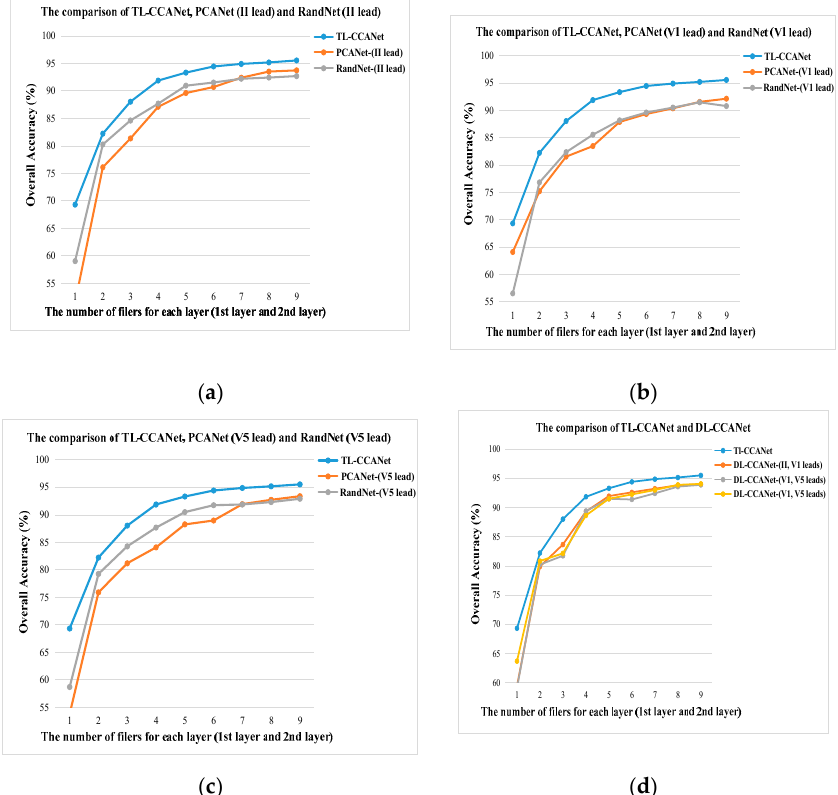
Figure 8. Classification results using different quantities of filters on INCART database. ( a ) TL-CCANet, PCANet (II) and RandNet (II); ( b ) TL-CCANet, PCANet (V1) and RandNet (V1); ( c ) TL-CCANet, PCANet (V5) and RandNet (V5); ( d ) TL-CCANet, DL-CCANet.